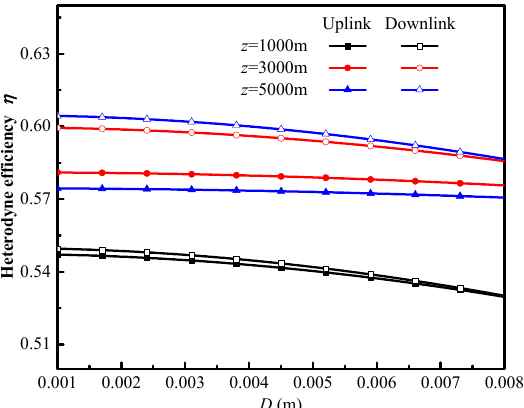
Figure 8. Effect of detector aperture D on the heterodyne efficiency of an uplink path and a downlink path.